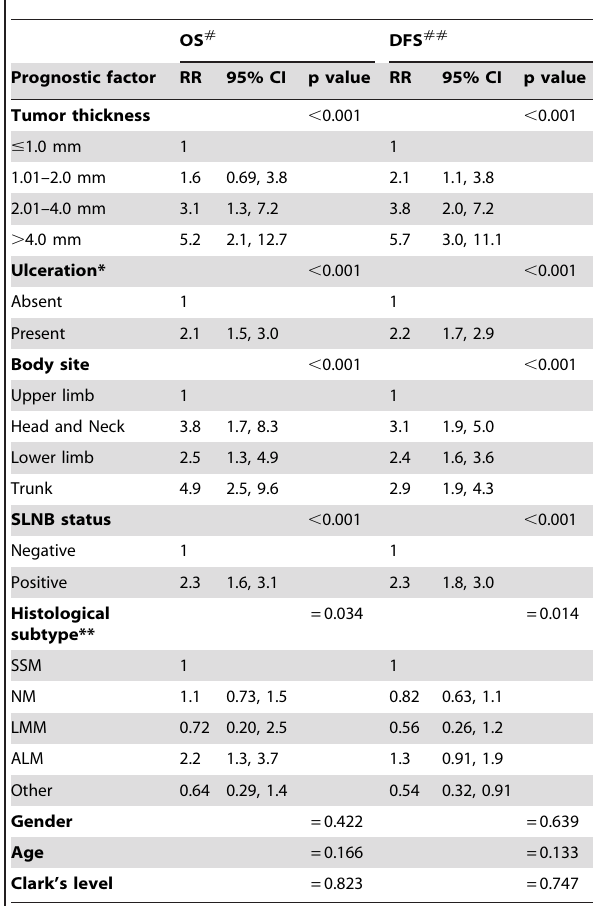
Table 3. Prognostic factors of overall (OS) and disease-free (DFS) survival in sentinel node-staged CM patients (n=1909). Results of multivariate Cox proportional hazard analysis.